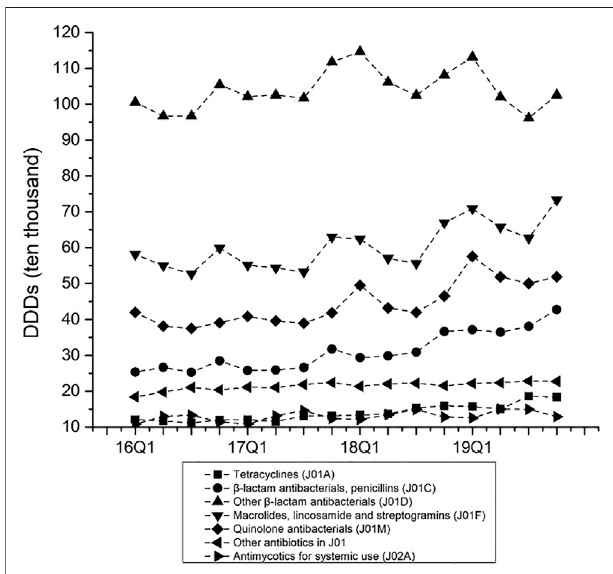
FIGURE 5 | Changes in antibiotics use by ATC classi fi cation, 2016 –